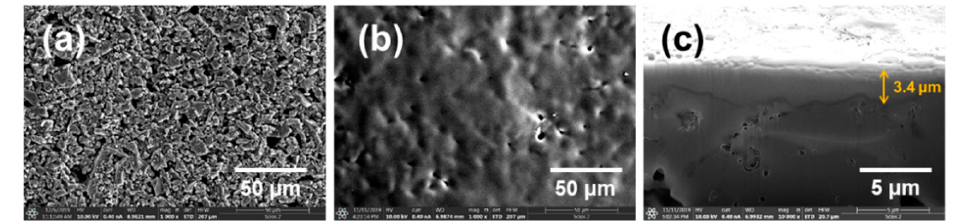
Figure 2. SEM image of surface of activated carbon electrode ( a ); SEM images of surface ( b ) and cross-section ( c ) of the activated carbon electrode coated by the cation polymer layer.